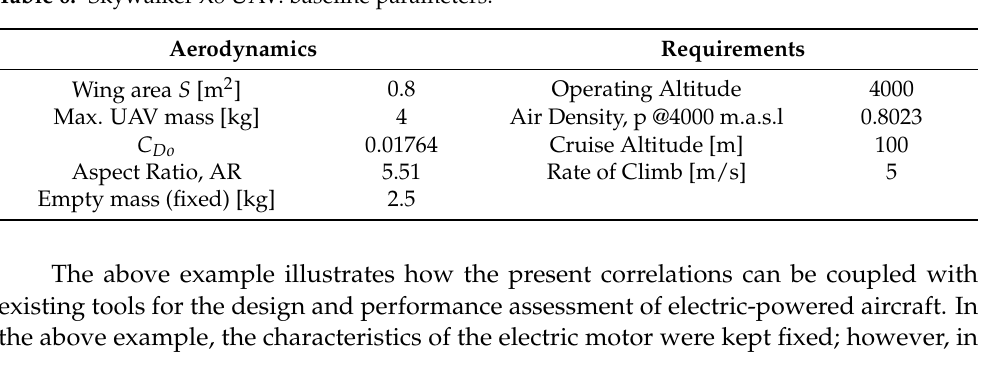
Figure 10. Effect of battery capacity on the UAV endurance using two formulations of the endurance equation [49]. Table 6. Skywalker X8 UAV: baseline